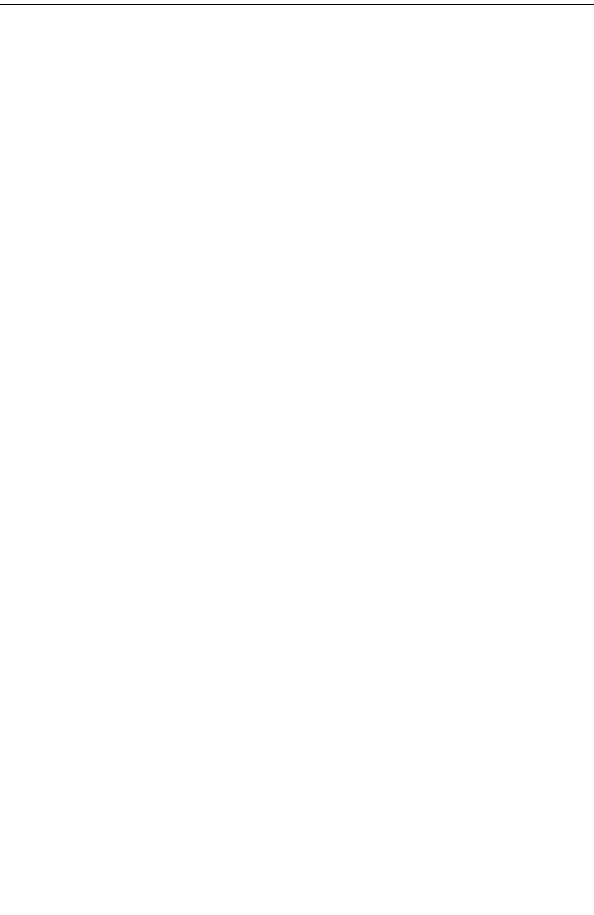
FIGUREA1 | Electrostatic potential map of the predicted three dimensional structure of DIL domains fromArabidopsis class XI myosins and yeast Myo2p and Myo4p DIL domains. Swiss-Pdb-Viewer 4.0.2 (Guex and Peitsch, 1997) was used to calculate the molecular surface electrostatic potential based on charged residue coulombic potential. A color gradient from blue to white to red is used to color the molecular surface, where blue, red, and white are for positive, negative, and neutral potentials, respectively, according to the given cutoff values. In the calculation, solvent and protein dielectric constants were taken as 80 and 4.0,